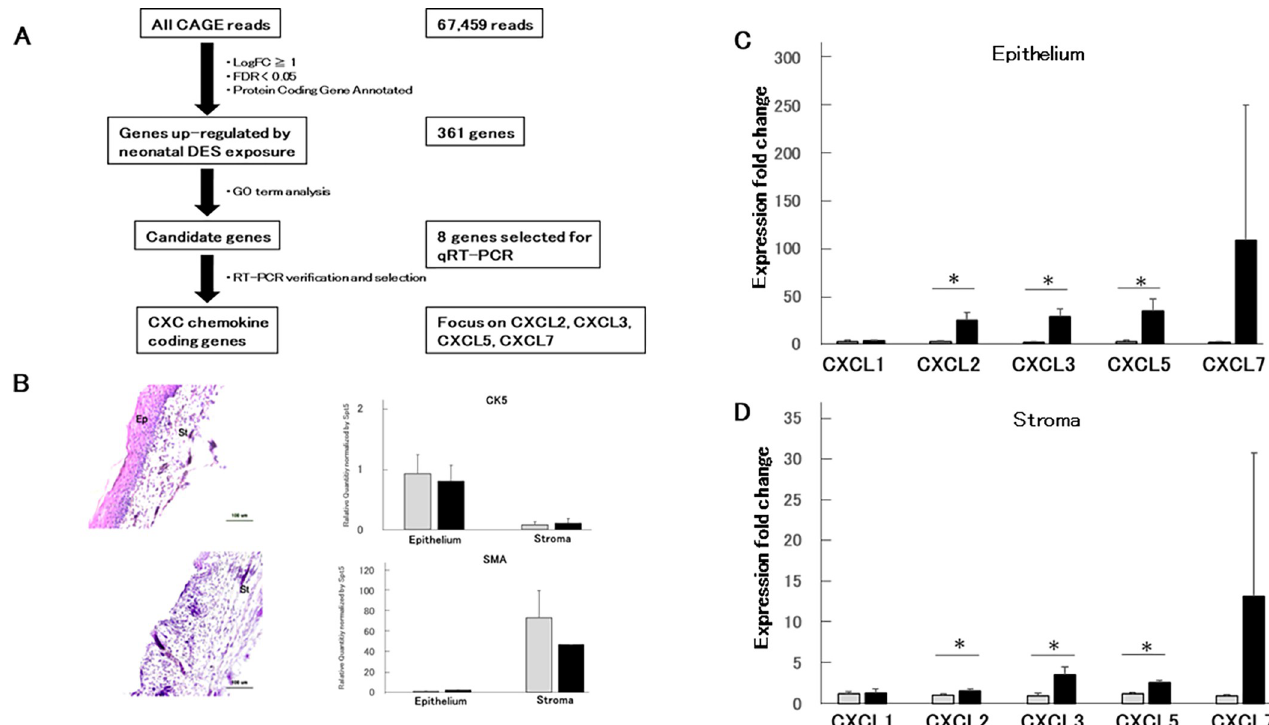
Fig 2. Epithelium-stroma separation method and Cxcl chemokine expression. (A) The procedures of tissue separation from the intact vagina are illustrated. See Materials and Methods for more details. OVX and sacrifice were performed at 8 th week and 10 th week after birth, respectively. (B) The separated epithelium and stroma were subjected to H&E stained (Ep, Vagina Epithelium; St, Vagina Stroma) and total RNA extraction following qPCR analysis. Expression fold changes of CK5 (keratin 5) and SMA ( α -smooth muscle actin) genes between epithelium and stroma. Boxes in gray and black indicate neoOil and neoDES, respectively. Expression fold change between neoOil and neoDES in the epithelium (C) or stroma (D). Genes indicated were analyzed (n = 3; t-test, � p < 0.05).